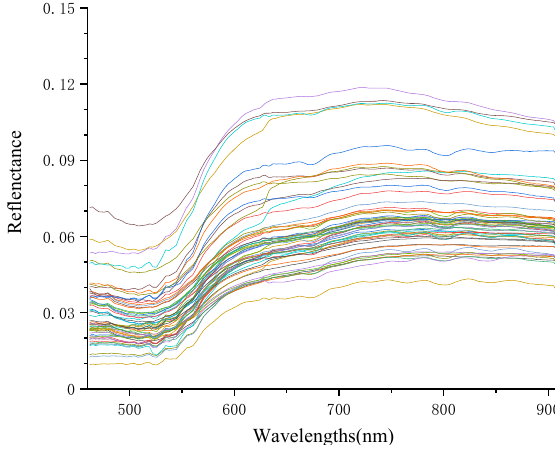
Figure 2. Average spectra each of the samples (59 samples ).